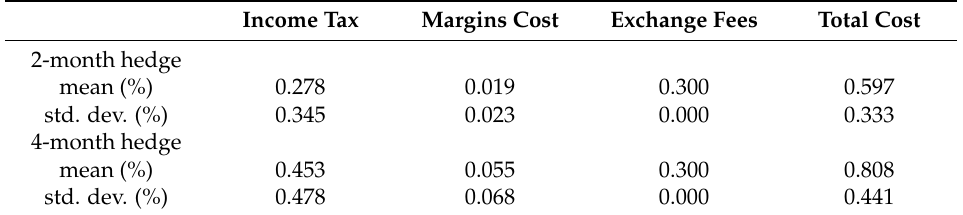
Table 1. Mean and standard deviation of transaction costs in futures trading based on simulated price trajectories with annual price volatility of 10% (a) .